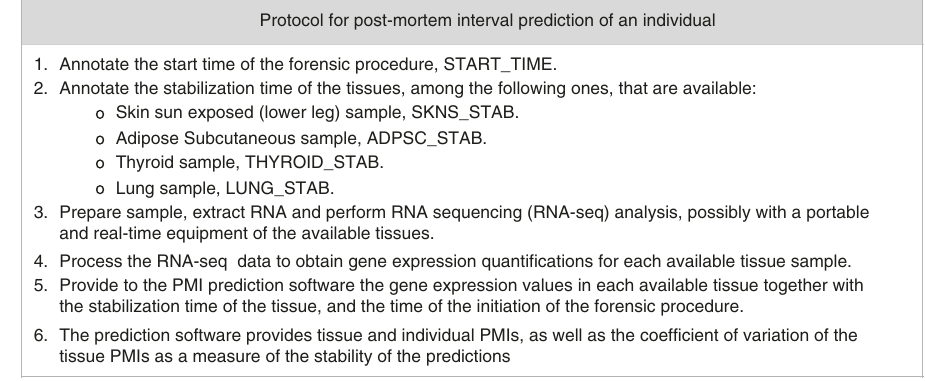
Fig. 9 Protocol for post-mortem interval prediction. Steps to be performed to predict the PMI of an